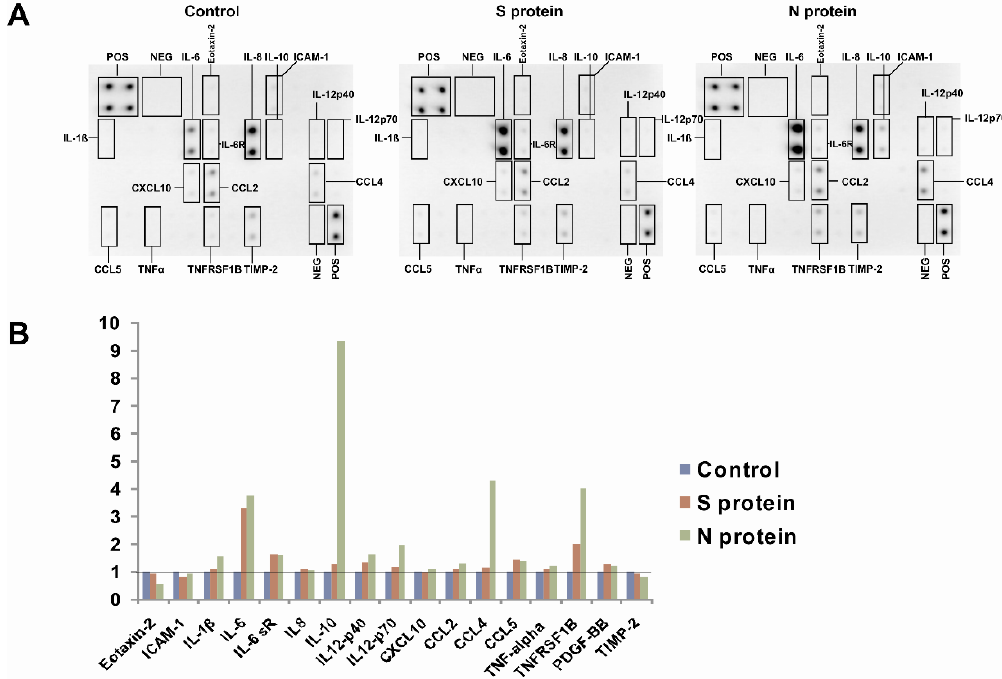
Figure 1. Effect of the S and N proteins of the severe acute respiratory syndrome coronavirus 2 (SARS-CoV-2) virus on the induction of inflammatory proteins in monocytes. ( A ) Human monocytes isolated from peripheral blood mononuclear cells (PBMCs) were cultured for 3 days in the presence of 1 µ g/mL S protein and 1 µ g/mL N protein. Control cells were treated with an equal volume of phosphate-buffered saline (PBS). The supernatants from these cultures were analyzed by the Human Inflammation Array C3 (AAH-INF-3, RayBiotech). ( B ) Quantification of dots from upper panel performed using Analysis Tool for AAH-INF-3 (RayBiotech). Results are shown as fold induction over control-treated